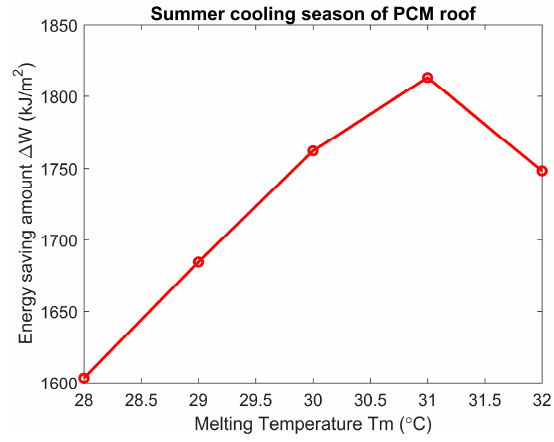
Figure 6. The effect of the melting temperature on the PCM roof energy saving amount.